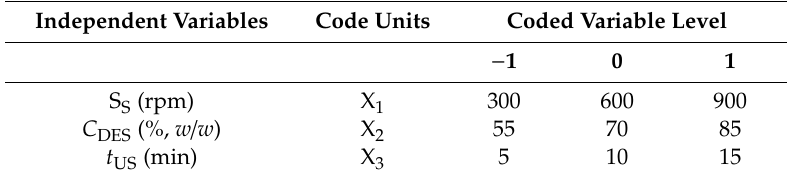
Table 1. Actual and coded levels of the independent variables selected to set up the experimental